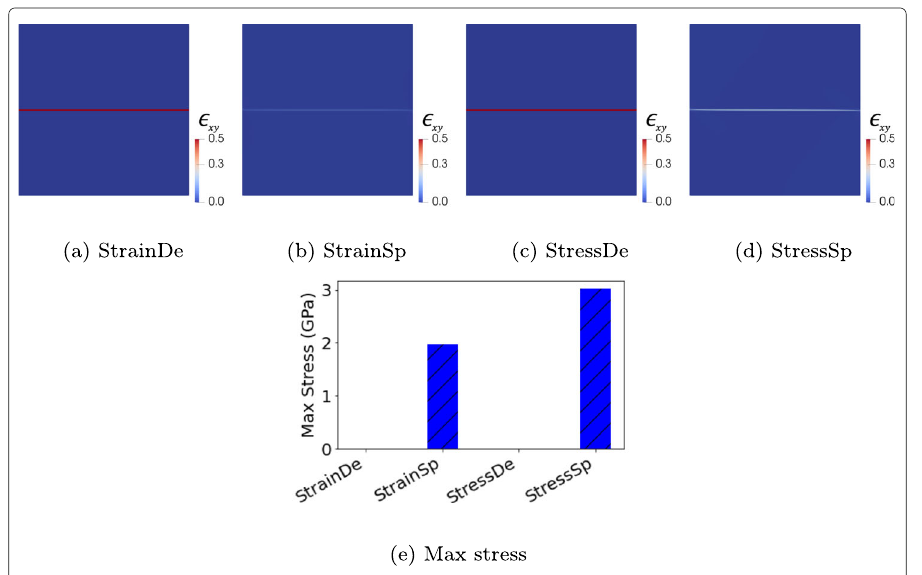
Fig. 4 Mechanical response of the cracked material under shear load predicted by the four methods: ( a ) - ( d ) shear strain distribution for the strain deviatoric, strain spectral, stress deviatoric, and stress spectral methods, respectively; ( e ) maximum shear stress throughout the